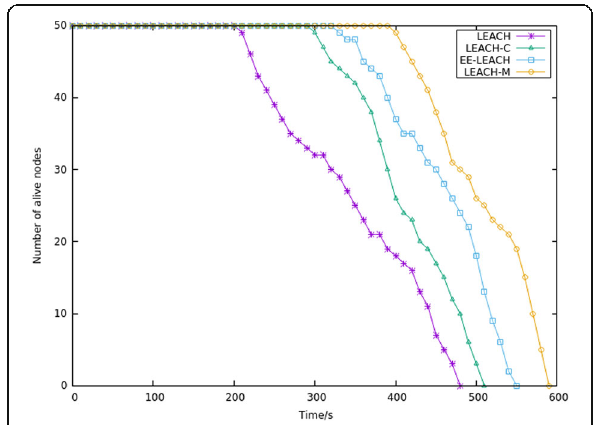
Fig. 8 The comparison of alive nodes for LEACH, LEACH-C, EE-